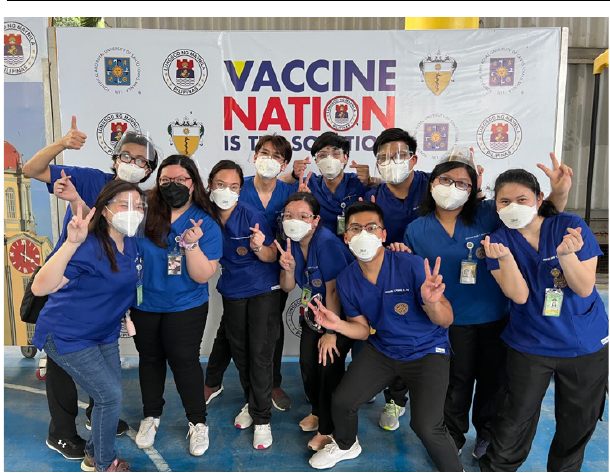
Figure 4 . PGIs as volunteers during a COVID-19 vaccination drive for the pediatric population in Manila,